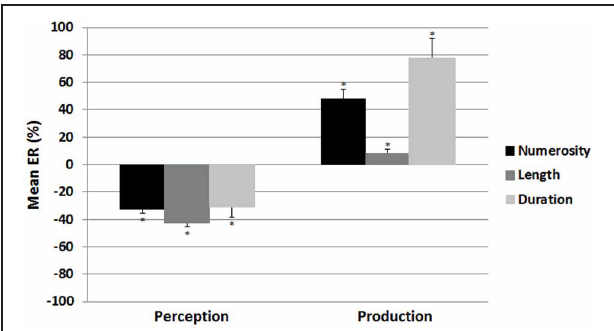
FIGURE 3 | Mean error rate as a function of condition (perception vs. production) and magnitude (numerosity, length, vs. duration) in Experiment 1. A significant underestimation was observed in the perception tasks, whereas a significant overestimation was observed in the production tasks, for the three magnitudes. Error bars denote Standard Error of the Mean (SEM); asterisks indicate significant differences compared to